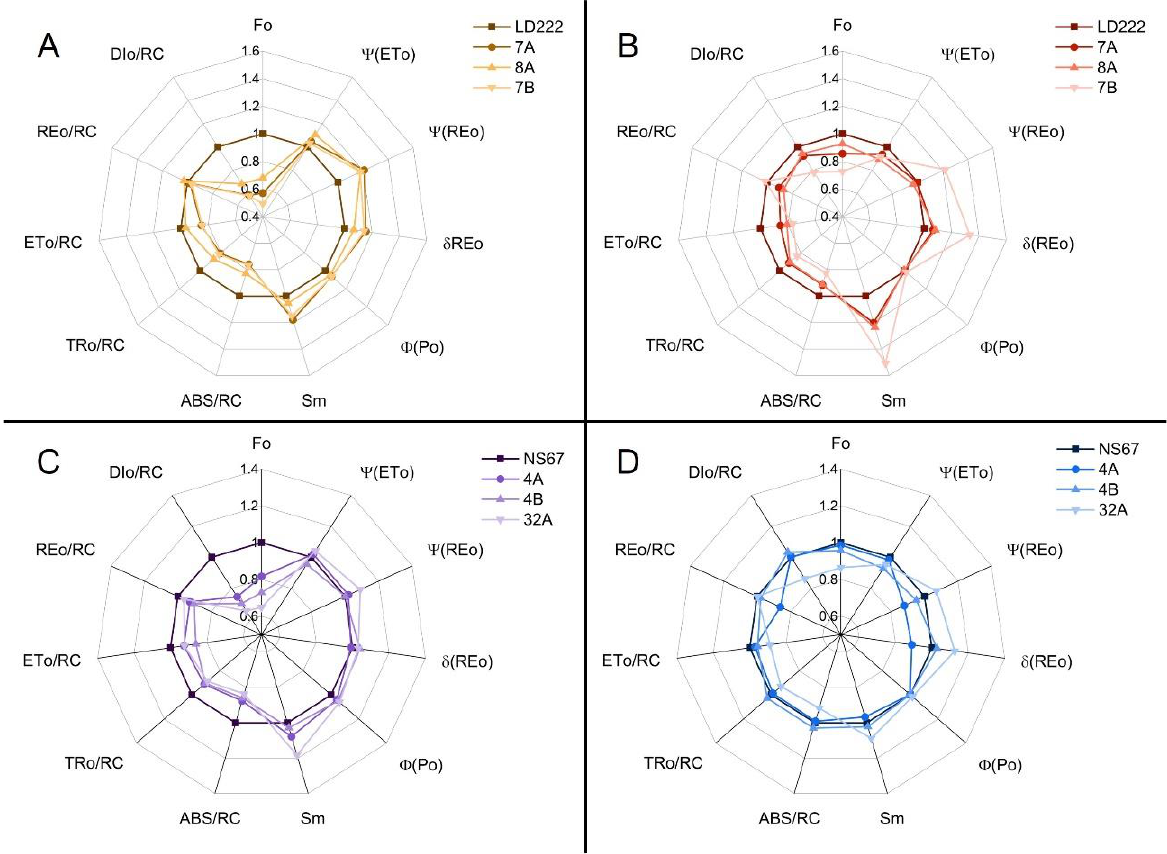
Figure 5. Spider plots of selected fast-chlorophyll- a -fluorescence-derived parameters calculated according to the “Energy Fluxes” model in young and mature leaves of durum- and bread-wheat plants. Each point represents the average value normalized on the respective average value of the wild-type line (LD222 in durum wheat, NS67 in bread wheat) for n = 8–12 replicates. ( A , B ) Spider plots of young ( A ) and mature ( B ) durum-wheat lines. ( C , D ) Spider plots of young ( C ) and mature ( D ) bread-wheat lines. For the definition of the parameters, see Appendix B.